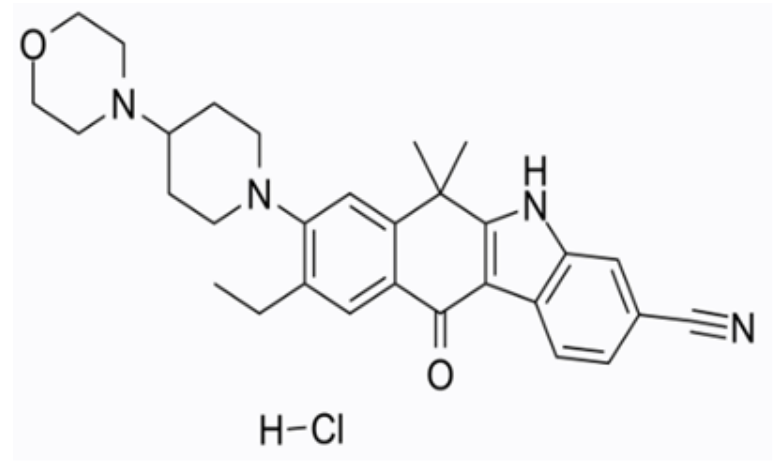
Figure 1. Structure of alectinib hydrochloride.